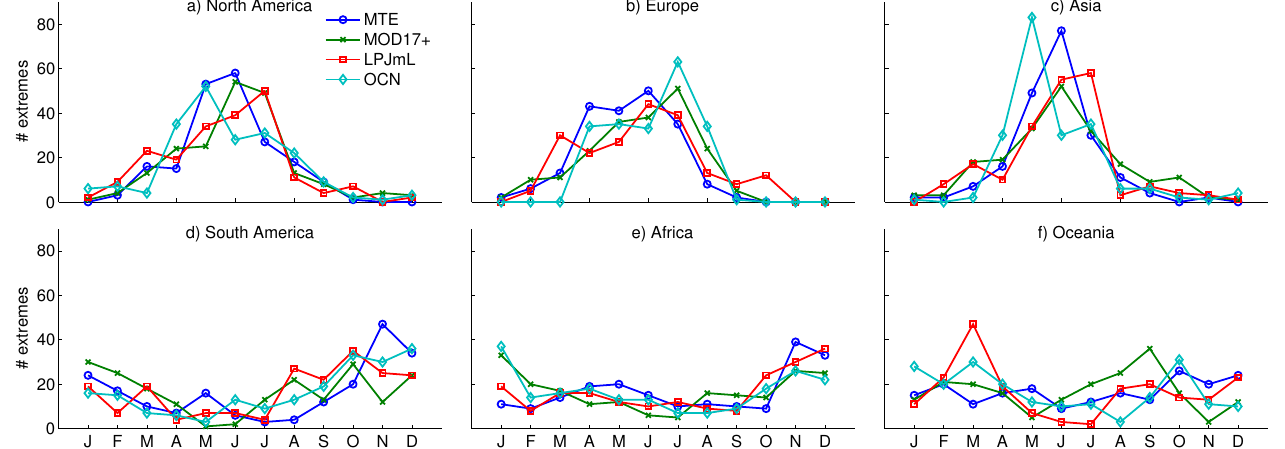
Figure 8. Number of GPP extreme events starting per month for the largest 200 1st-percentile extremes in GPP for each continent and the data sets MTE, MOD17+, LPJmL,